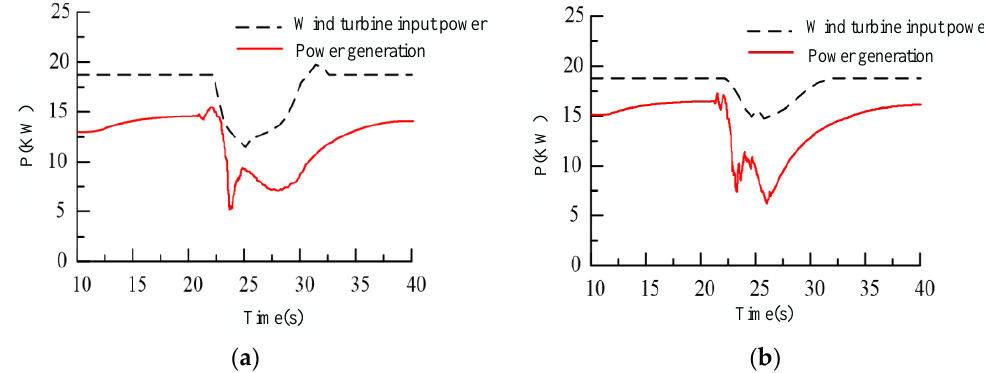
Figure 10. Simulation curve of HWT voltage drop when using top-level control. ( a ) Power curve when single-phase drops by 80%; ( b ) Power curve when three-phase drops by 20%.